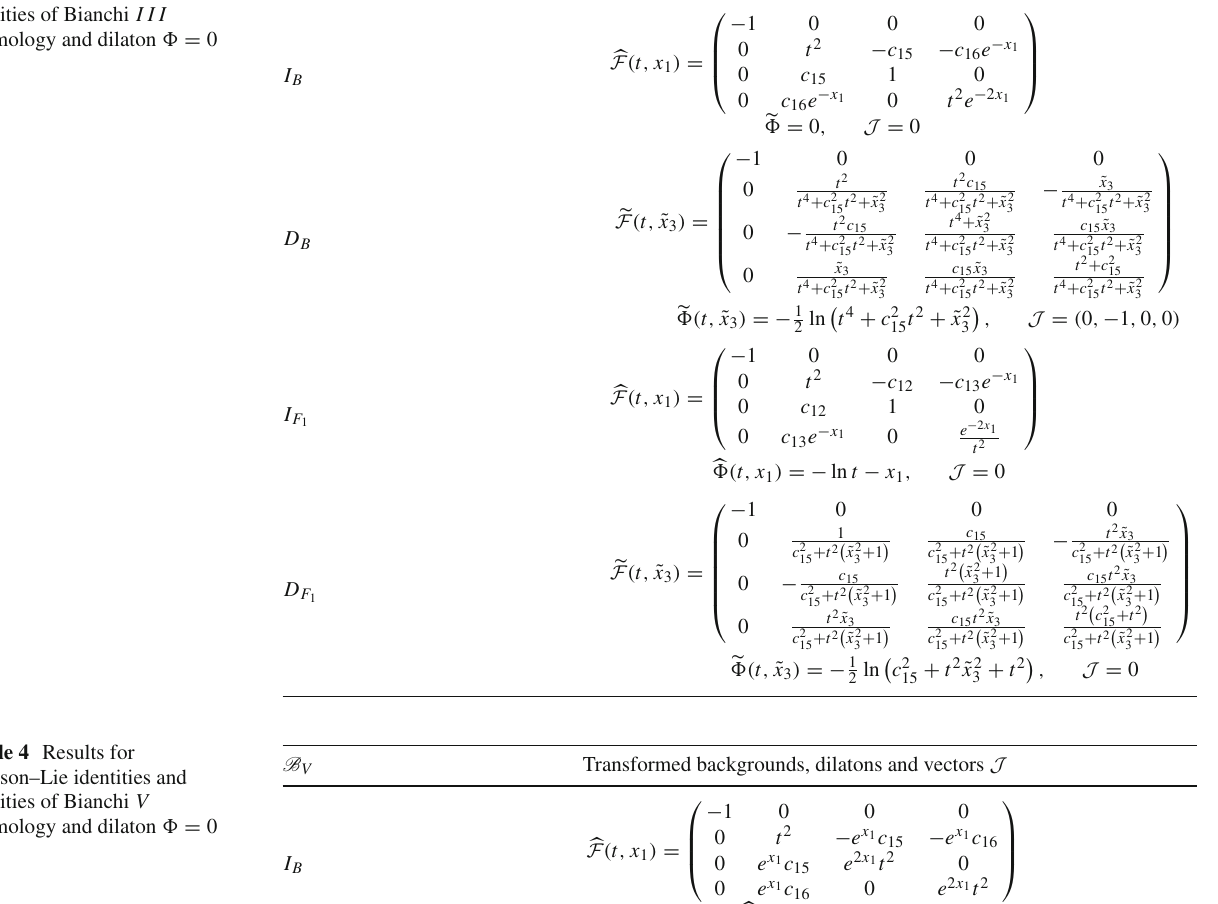
Table 3 Results for Poisson–Lie identities and dualities of Bianchi I I I cosmology and dilaton (cid:14) = 0